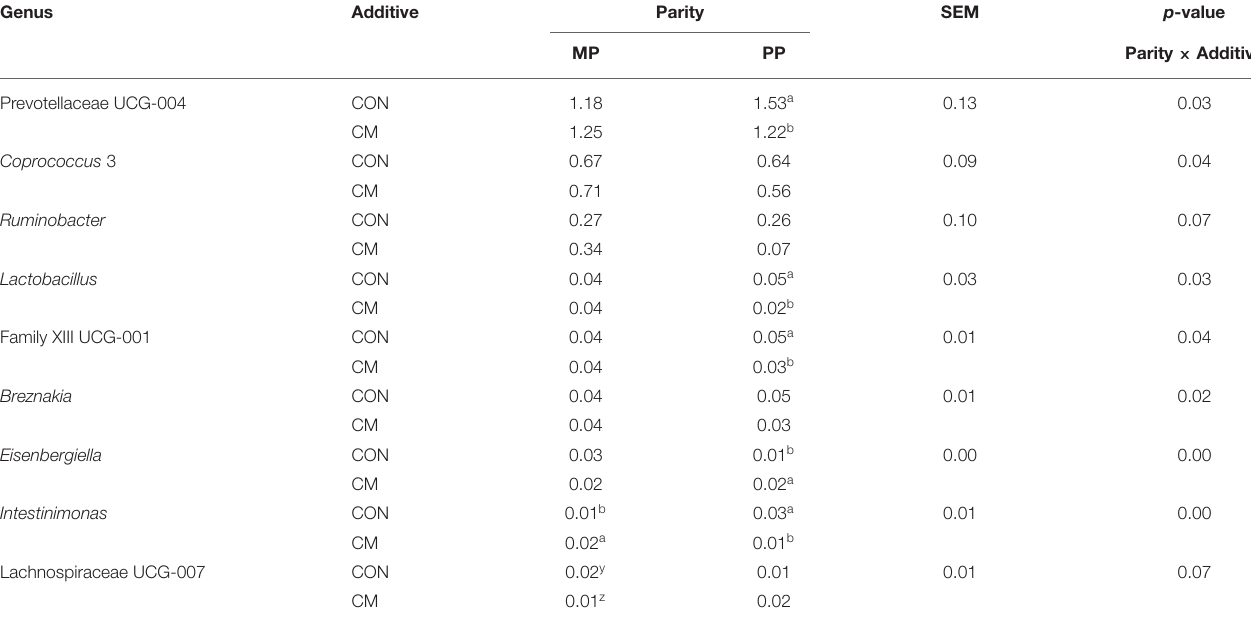
TABLE 3 | Relative abundance of bacterial genera significantly ( p ≤ 0.05) or tendentially (0.05 < p ≤ 0.10) affected by an interaction of feed additive (CM) with parity.